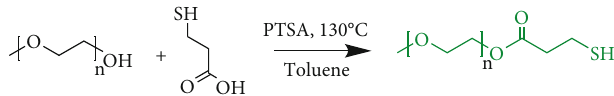
Scheme 2: Thiolation of polyethylene glycol momomethyl ethers with